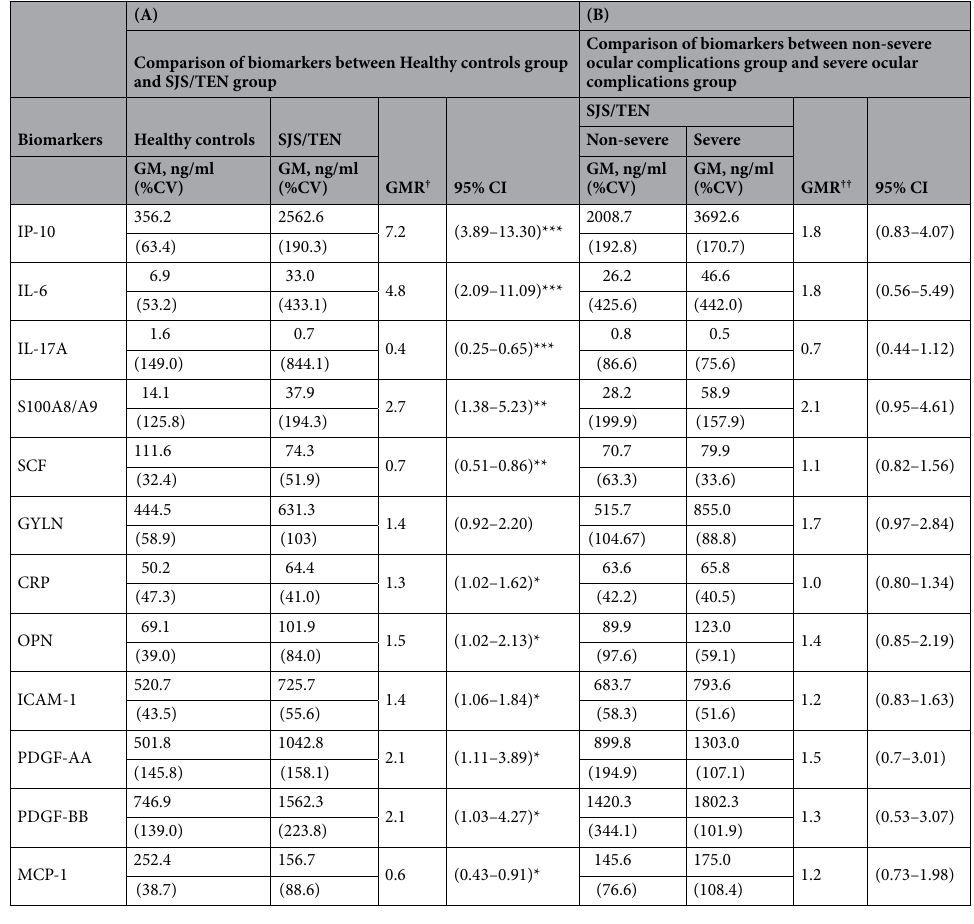
Table 4. The comparison of serum biomarkers levels between healthy controls and SJS/TEN patients with different ocular severity. (A) Comparison between healthy controls group and SJS/TEN group. (B) Subgroup comparison between non-severe and severe ocular complications group. GM geometric mean; GMR geometric mean ratios; %CV percent coefficient of variation; IP-10 interferon-γ-inducible protein 10; IL-6 interleukin 6; S100A8/A9 heterodimeric of S100 calcium binding protein A8 and S100 calcium binding protein A9; SCF stem cell factor; GYLN granulysin; CRP C-reactive protein; OPN Osteopontin; ICAM 1 intercellular adhesion molecule 1; PDGF AA platelet-derived growth factor AA ; PDGF BB platelet-derived growth factor BB; MCP monocyte chemotactic protein 1. † GMR in column A = the quotient of SJS/TEN and Healthy